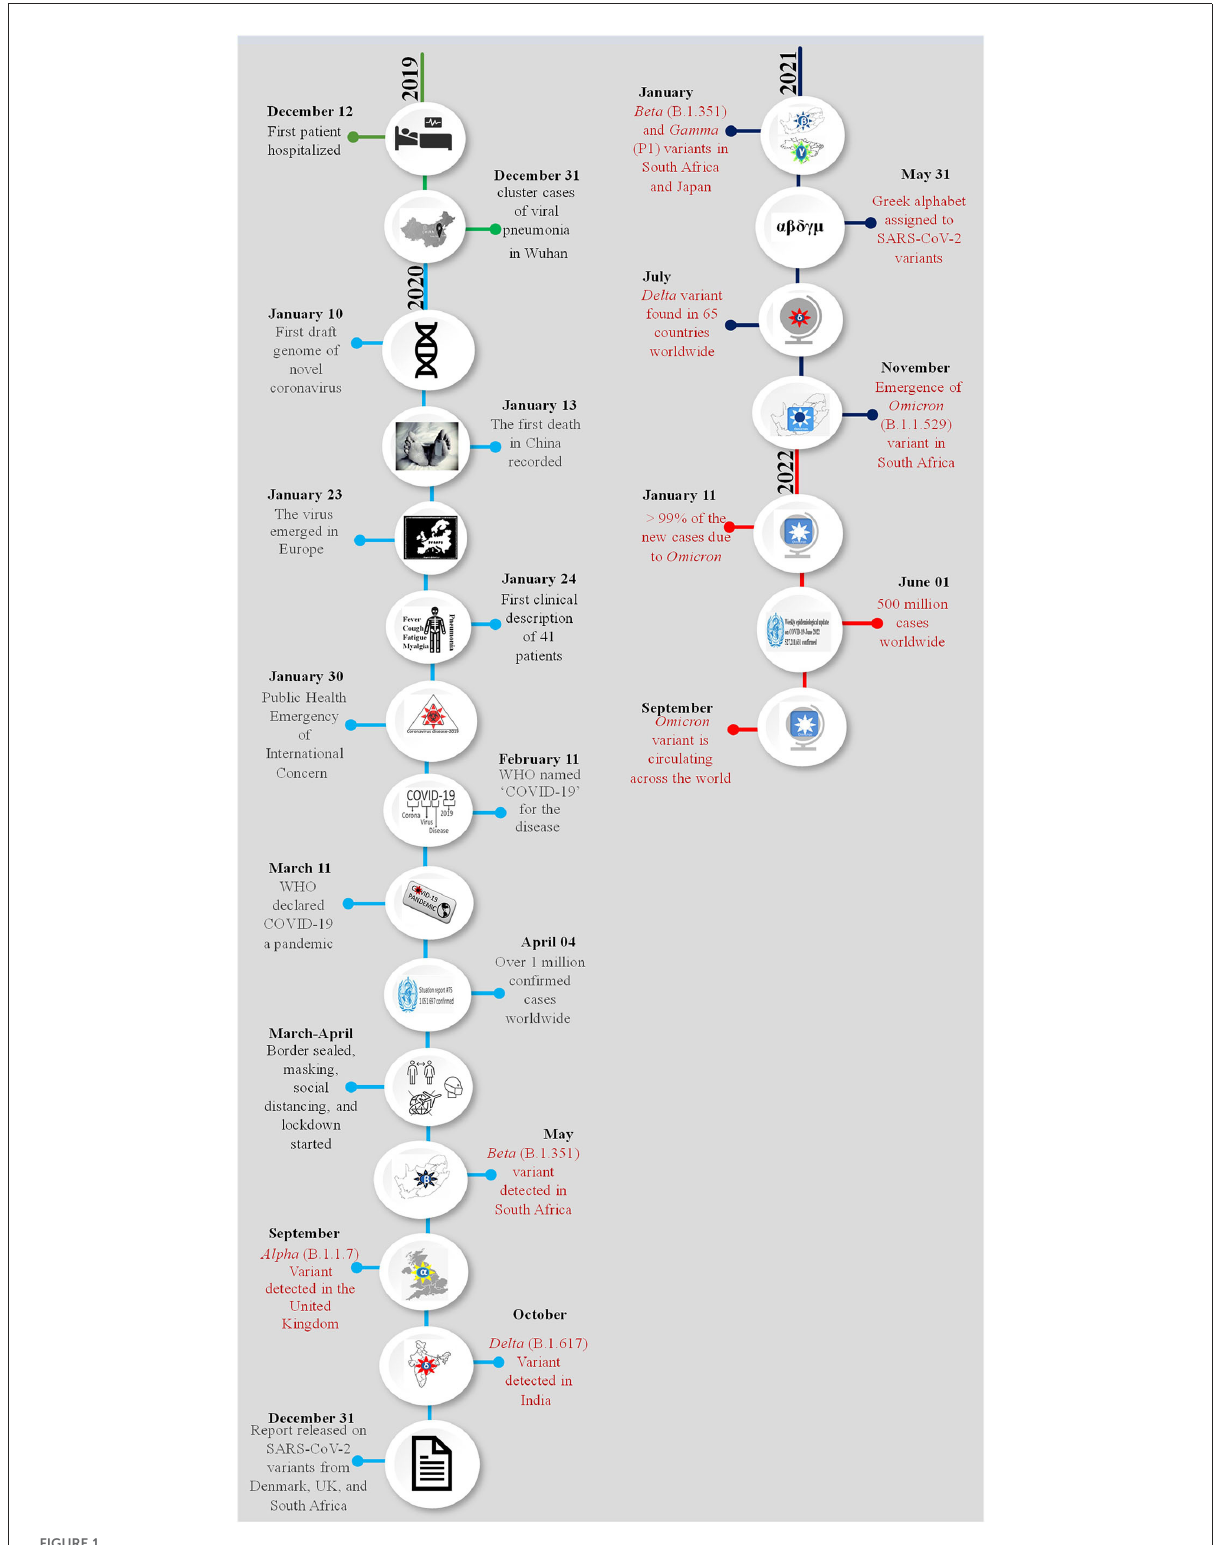
FIGURE1 Chronology of the emergence of SARS-CoV-2 variants during the pandemic. The month and date of the main events of the COVID-19 pandemic are presented year-wise and each year is shown with a different color. Appearance of a new variant and related information are highlighted with red color. A pictorial representation of each event has been added in the circle of respective date and